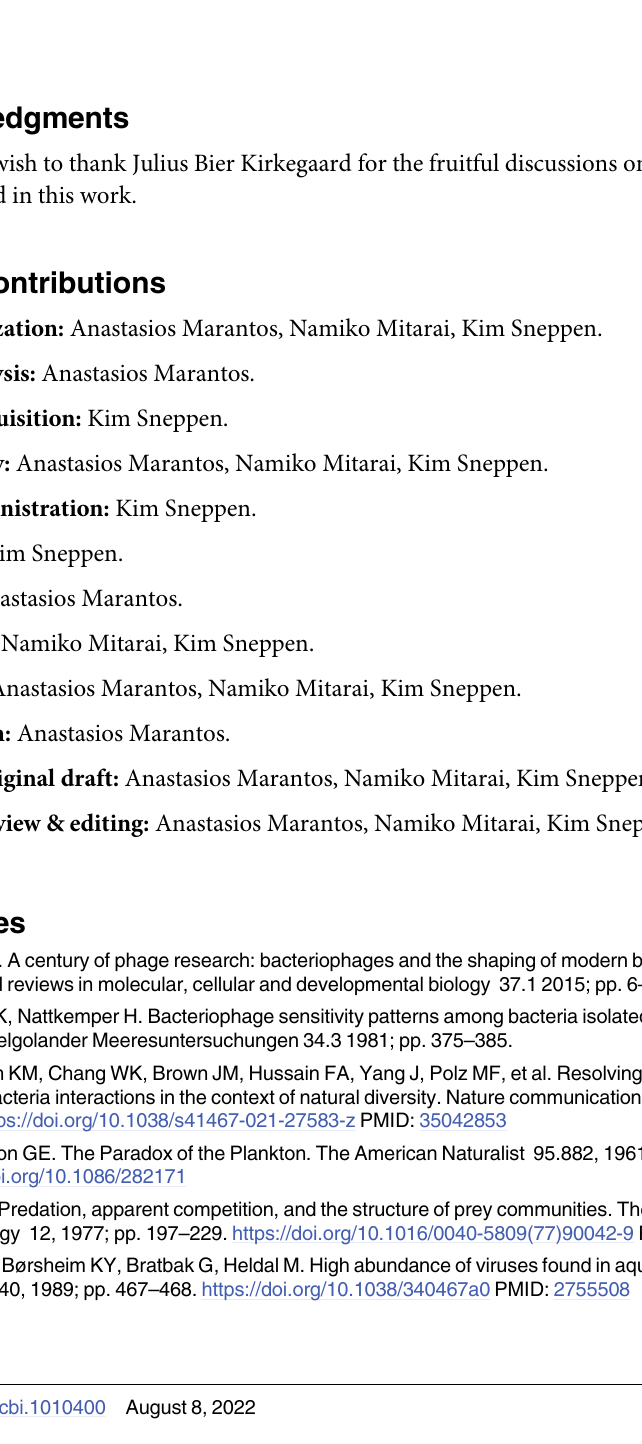
S2 Fig. Entry advantage related to growth rate. The central plot shows the relative entry advantage G of the fastest grower compared to the slower grower. The right subpanels display A the definition of G as G ¼ slope from the fitting of the distribution of the probability A A P entry ð k ¼ 0 : 3 Þ D k that a bacterial strain of growth rate k invades the system successfully. Both side panels corre- spond to model R but they would be practically the same for model N as one can see from the central